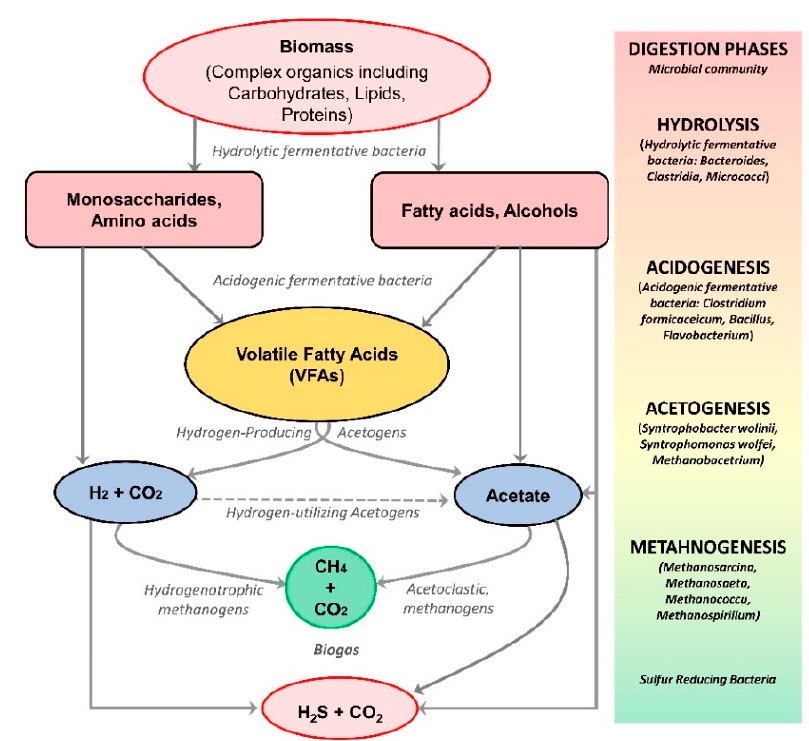
Figure 2. The four phases involved in anaerobic digestion of biomass showing the related microbial communities.